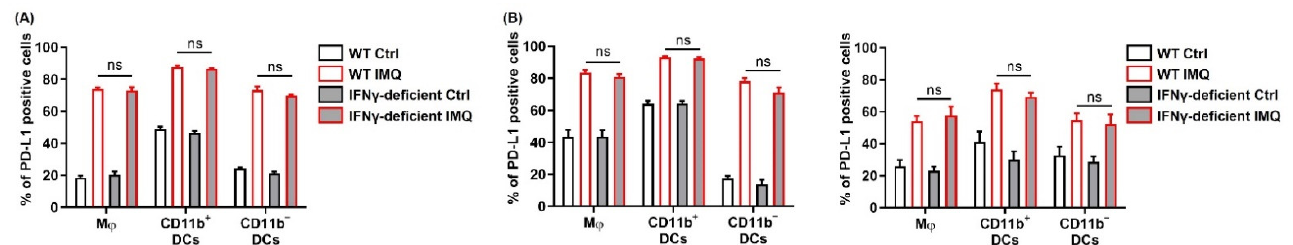
Figure 6. IFN- γ is not involved in the IMQ-induced upregulation of PD-L1 expression. ( A ) Flow cytometric analysis of PD-L1 expression in myeloid cells of the spleens of wildtype or IFN- γ -deficient mice stimulated with IMQ for 24 h ( n = 6 in each group). ( B ) Flow cytometric analysis of PD-L1 expression in the myeloid cells of the lymph nodes and tumors of wildtype or IFN- γ -deficient mice 5 days after tumor inoculation with IMQ application at day 4 ( n = 8 in wildtype mice with IMQ application or no treatment or IFN- γ -deficient mice with no treatment, n = 7 in IFN- γ -deficient mice with IMQ